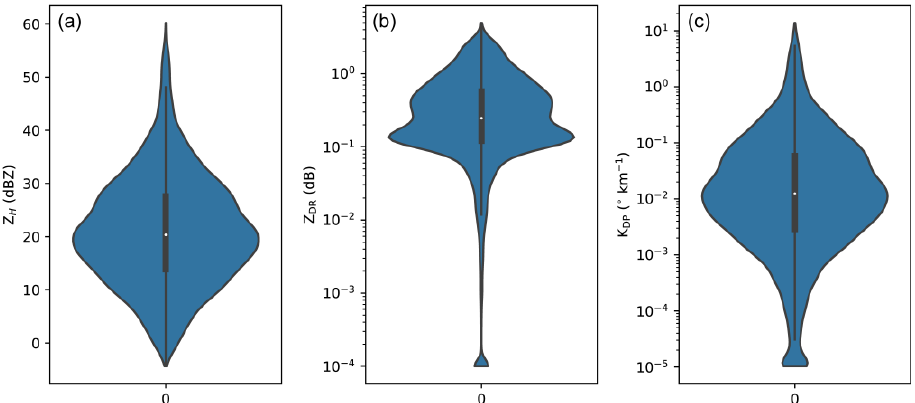
Figure 10. The distributions of ( a ) Z H , ( b ) Z DR , and ( c ) K DP derived from DSD measurements using the T -matrix scattering approach.